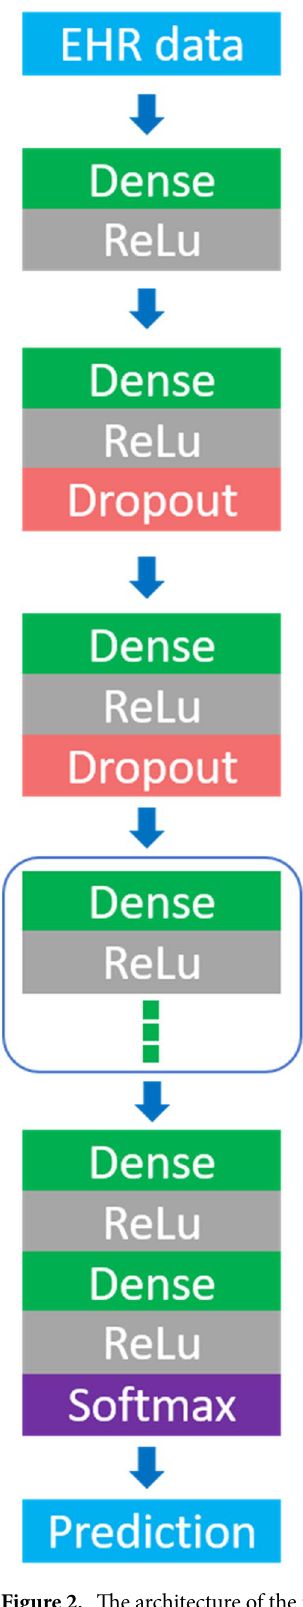
Figure 2. The architecture of the